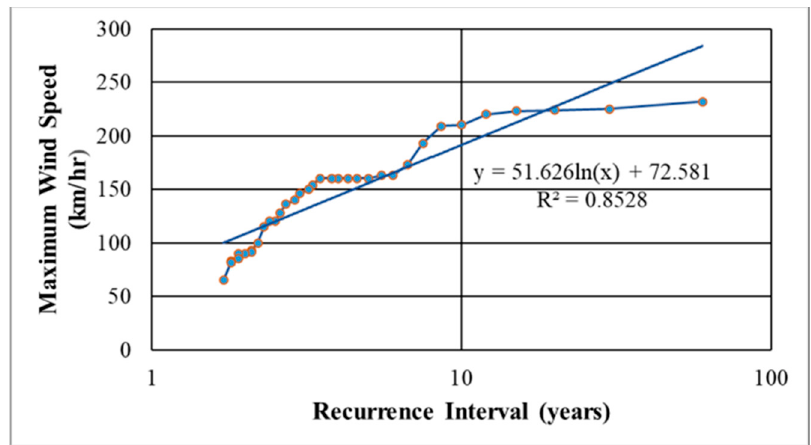
Figure 2. Frequency of cyclones making landfall in the study area.